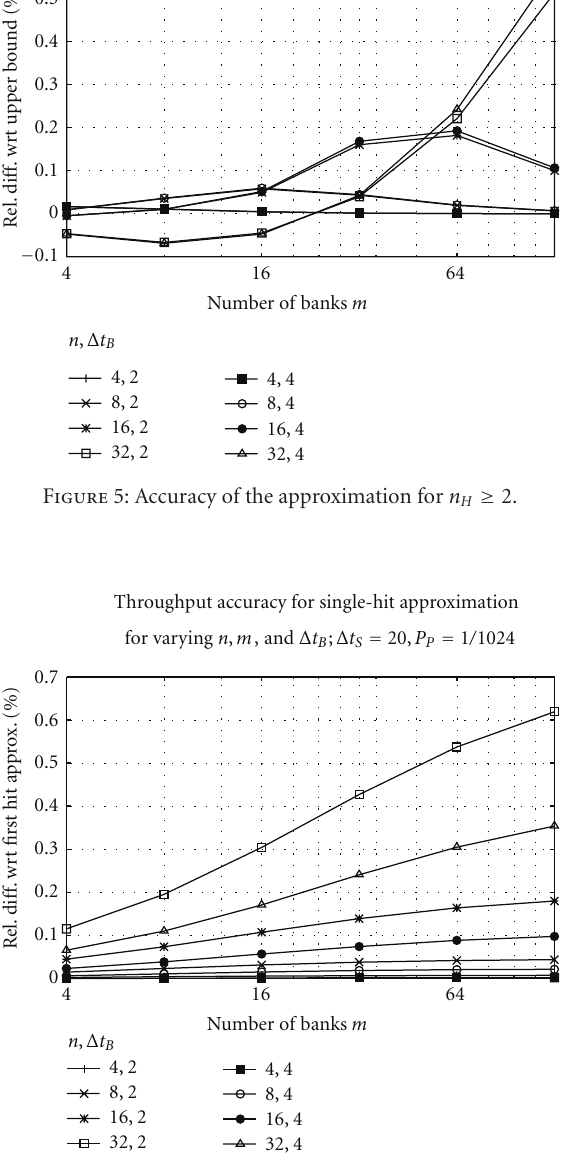
for Δ t B = 2, which illustrates that the condition Δ t S > p i Δ t B is su ffi cient but not necessary.